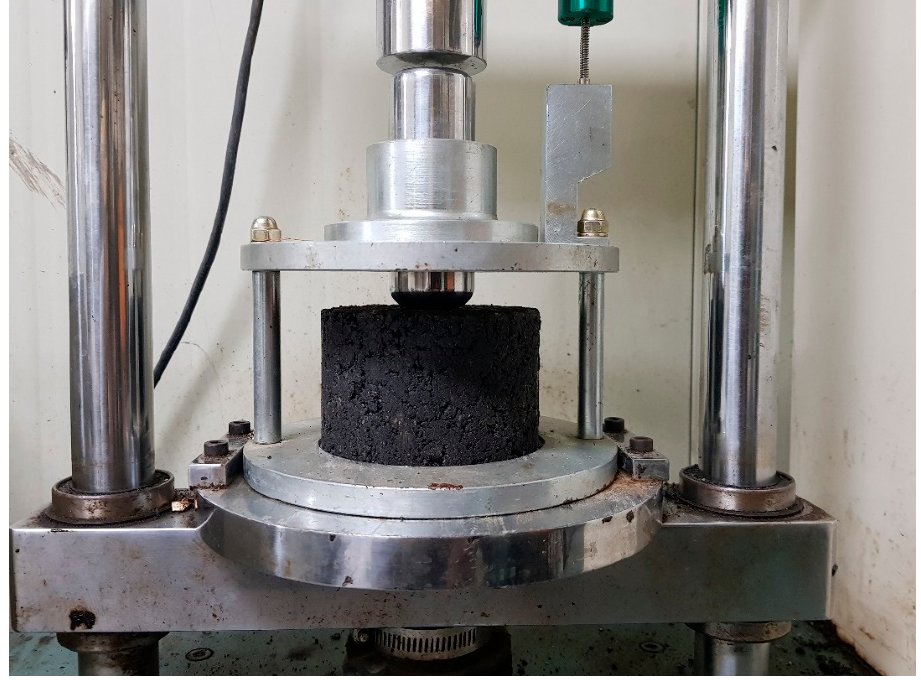
Figure 3. Kim test for deformation strength .